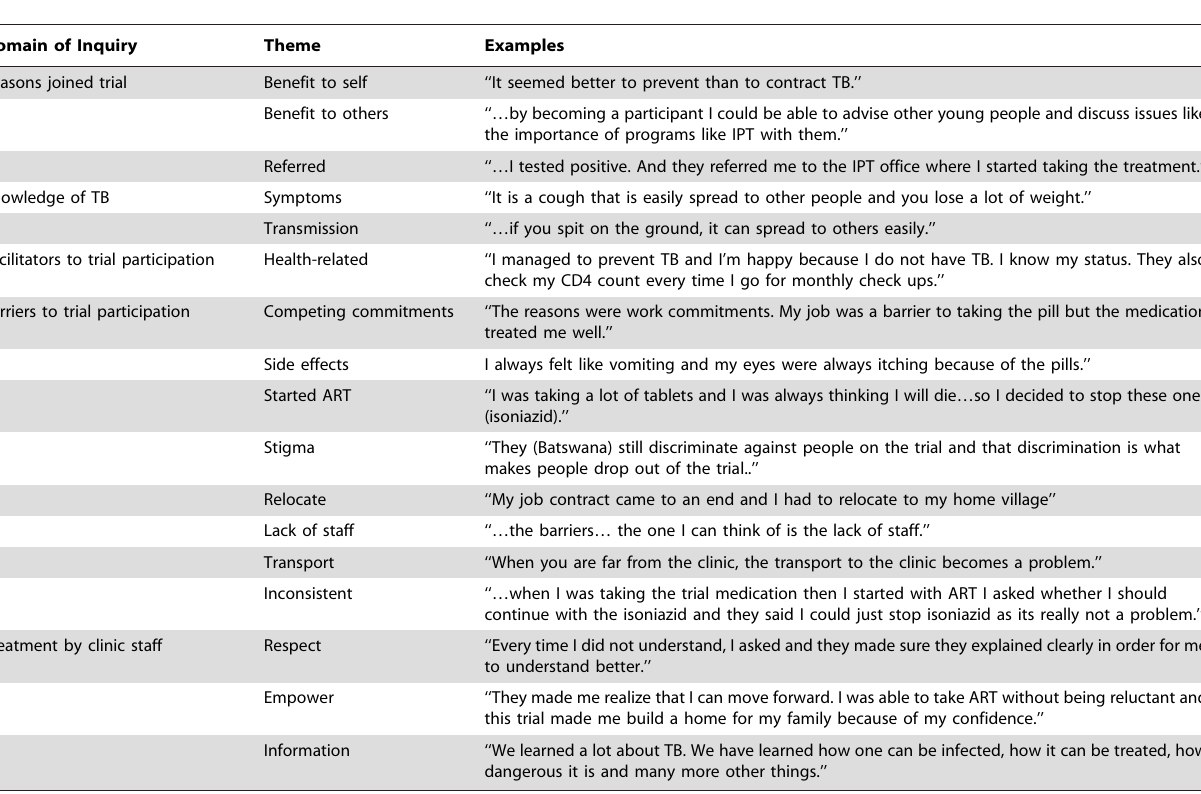
Table 2. Examples of group discussion and interview quotations from trial participants who were non-adherent to study medication or lost to follow-up in the Botswana Isoniazid Preventive Therapy Trial, 2004–2008.